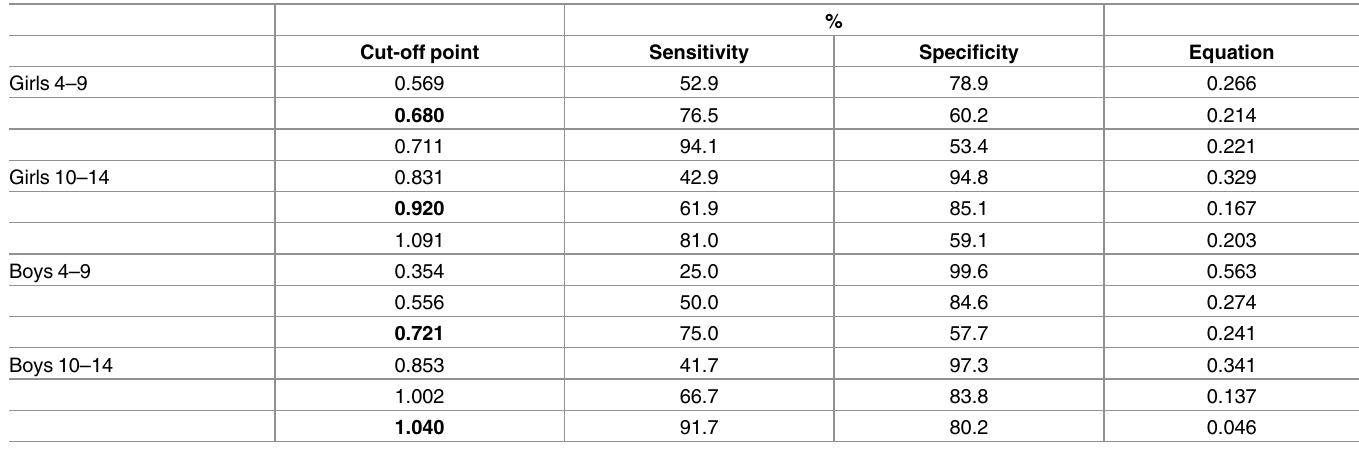
Table 3. Estimation of optimal cut-off point of grip-to-BMI